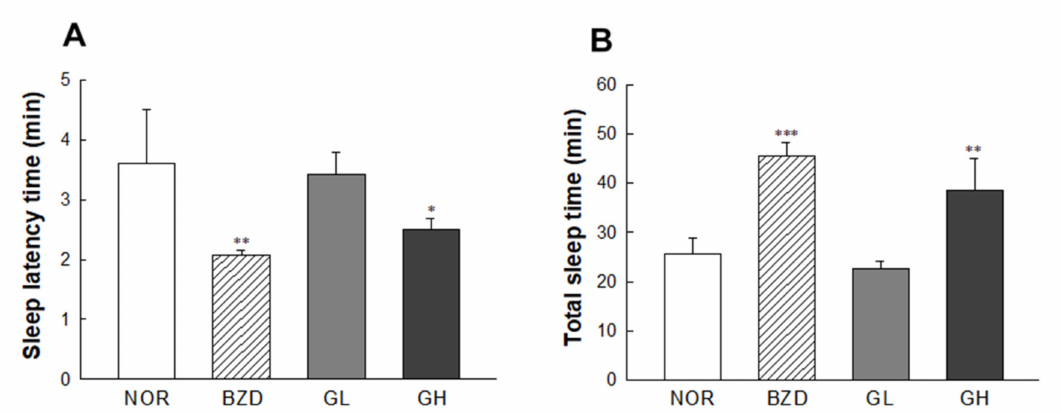
Figure 6. Effects of Lactobacillus -fermented γ -aminobutyric acid (LB-GABA) on ( A ) sleep latency time and ( B ) total sleep time in mice administered hypnotic dose of pentobarbital (42 mg/kg, intraperitoneally (i.p.)). Normal control (NOR): 0.9% sodium chloride (NaCl, physiological saline) group, BZD: benzodiazepine (alprazolam, 200 µ g/kg) treatment (positive control), GL and GH: low- and high-dose LB-GABA (60 and 100 mg/kg), respectively. Values are means ± standard deviation (SD); * p < 0.05, ** p < 0.01, and *** p < 0.001 versus normal control group according to Tukey’s multiple comparison